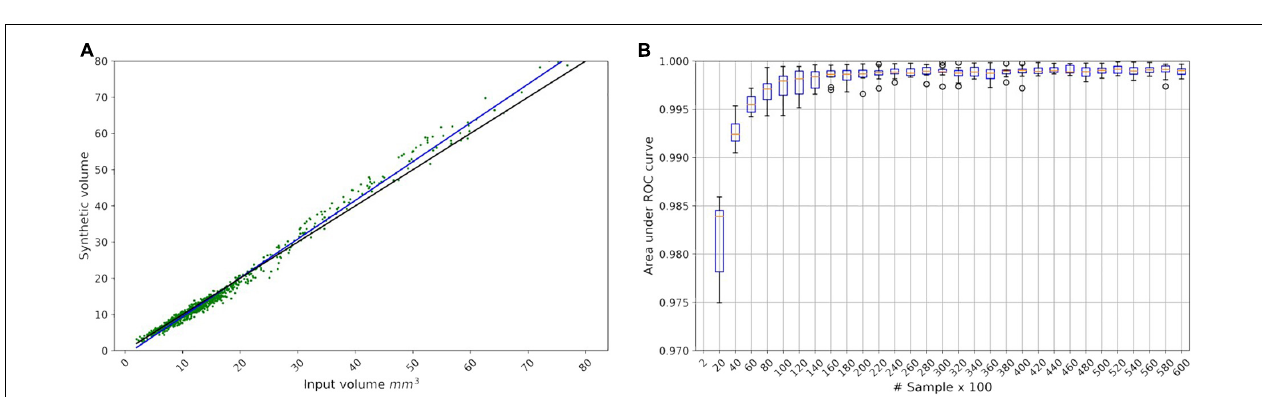
FIGURE 4 | Samples of generated sCMB from our proposed LesionGAN model for different volumes. Each row shows different sCMB with 10 different noises for a specific volume such as 5, 15, 20, and 30 mm 3 , respectively.